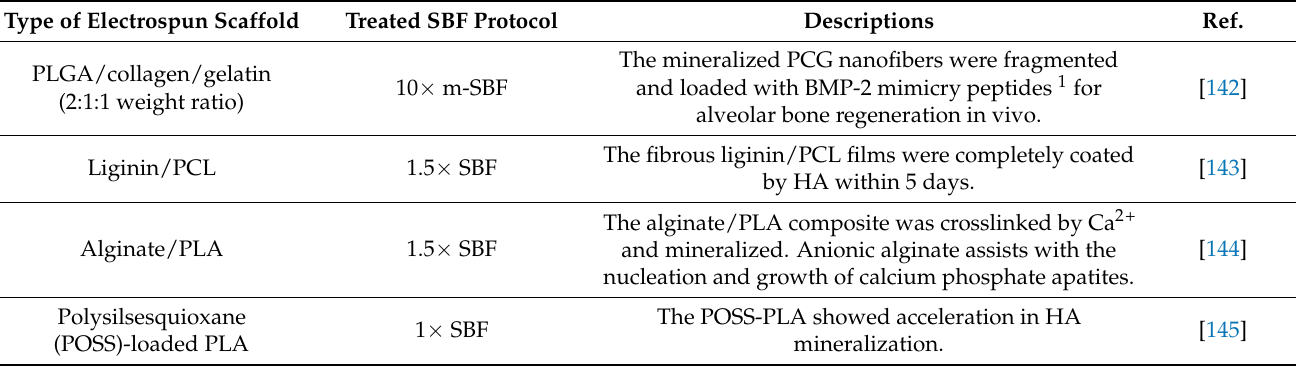
Table 4. Exemplary uses of simulated body fluid (SBFs) in electrospun-based bone scaffolds. Type of Electrospun Scaffold Treated SBF